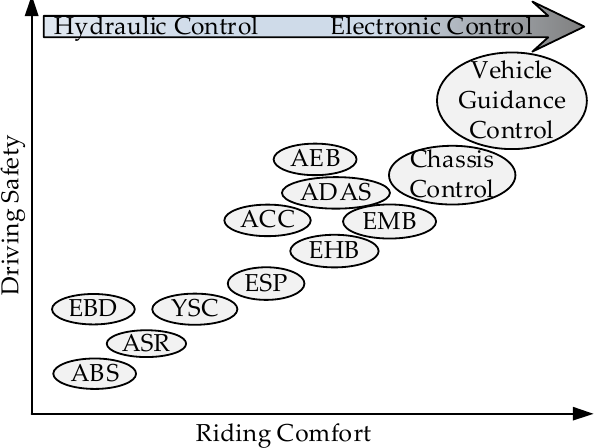
Figure 1. Development history and trend of vehicle brake system.